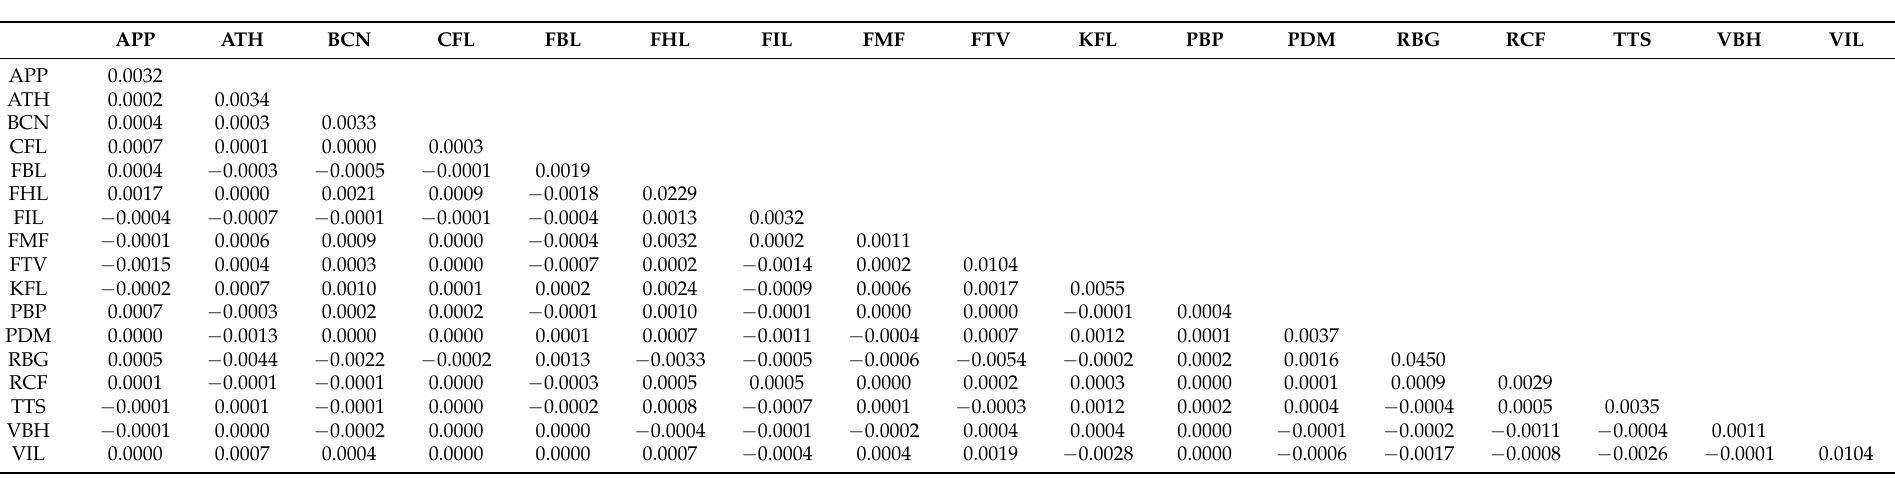
Table 13. Covariance of Returns Matrix.